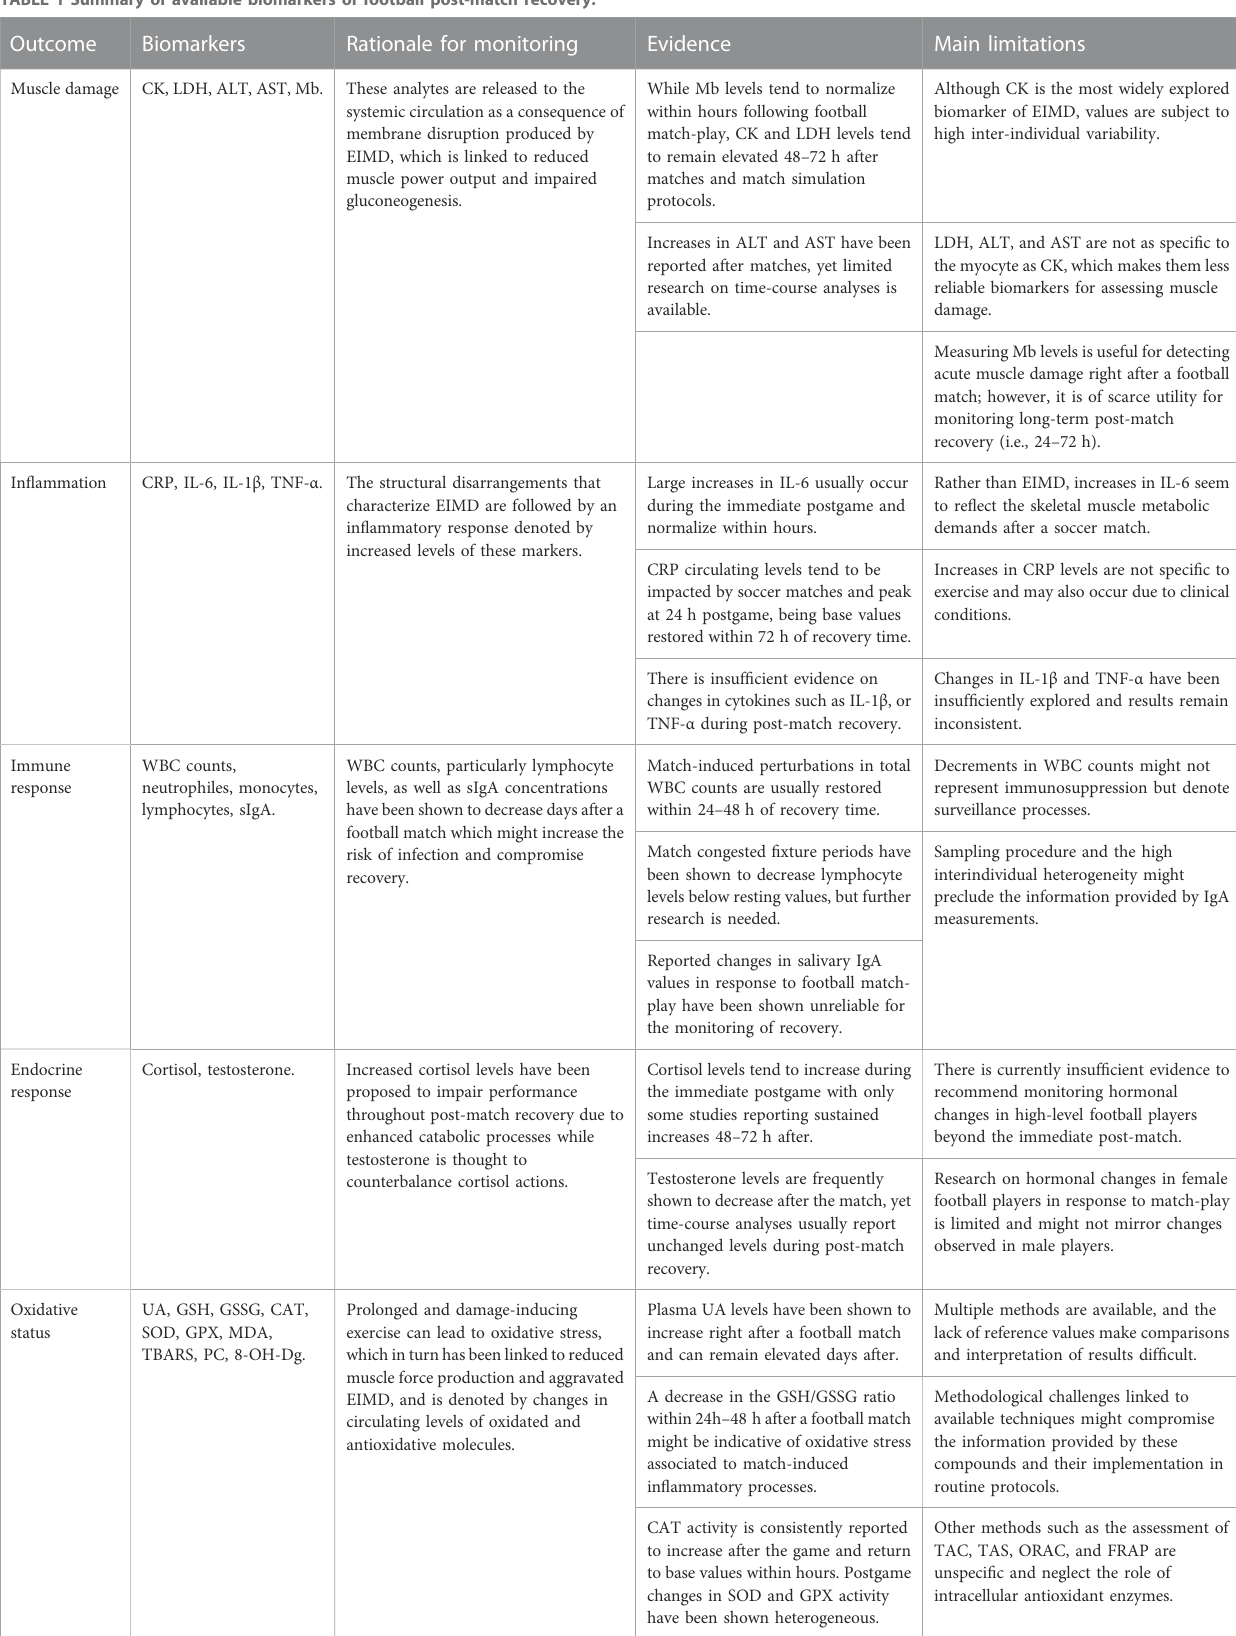
TABLE 1 Summary of available biomarkers of football post-match recovery.